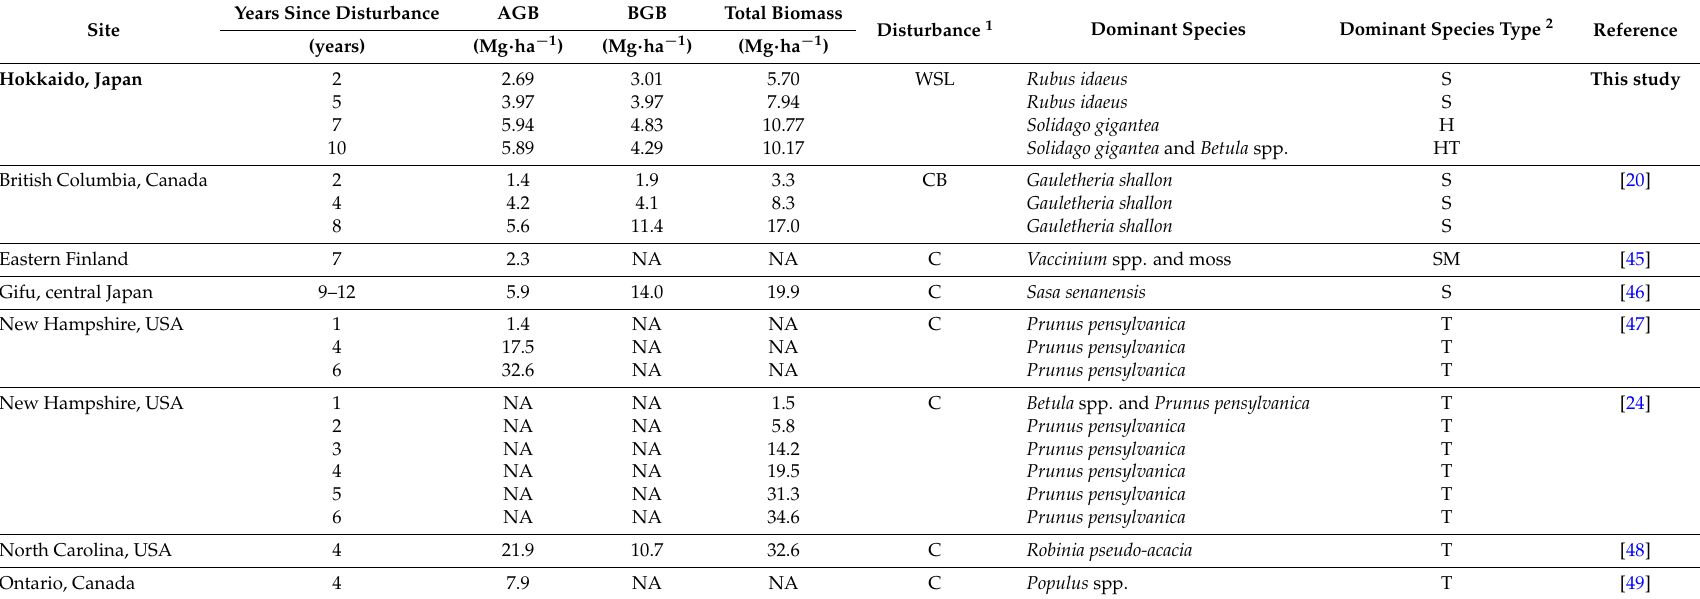
Table 3. Biomass accumulation in temperate and boreal sites after forest